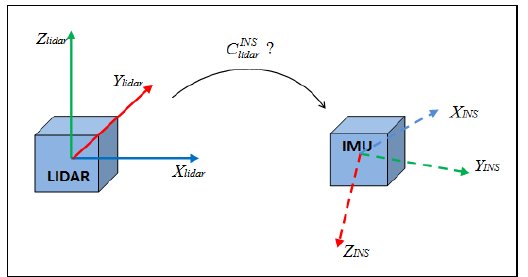
Figure 1 : Relative orientation between LiDAR and INS For terrestrial laser scanning, the error due to the boresight should be inferior to the cm-level in order to be lower to positioning uncertainty, which is less than 1cm with INS/GNSS hybridized post-processed